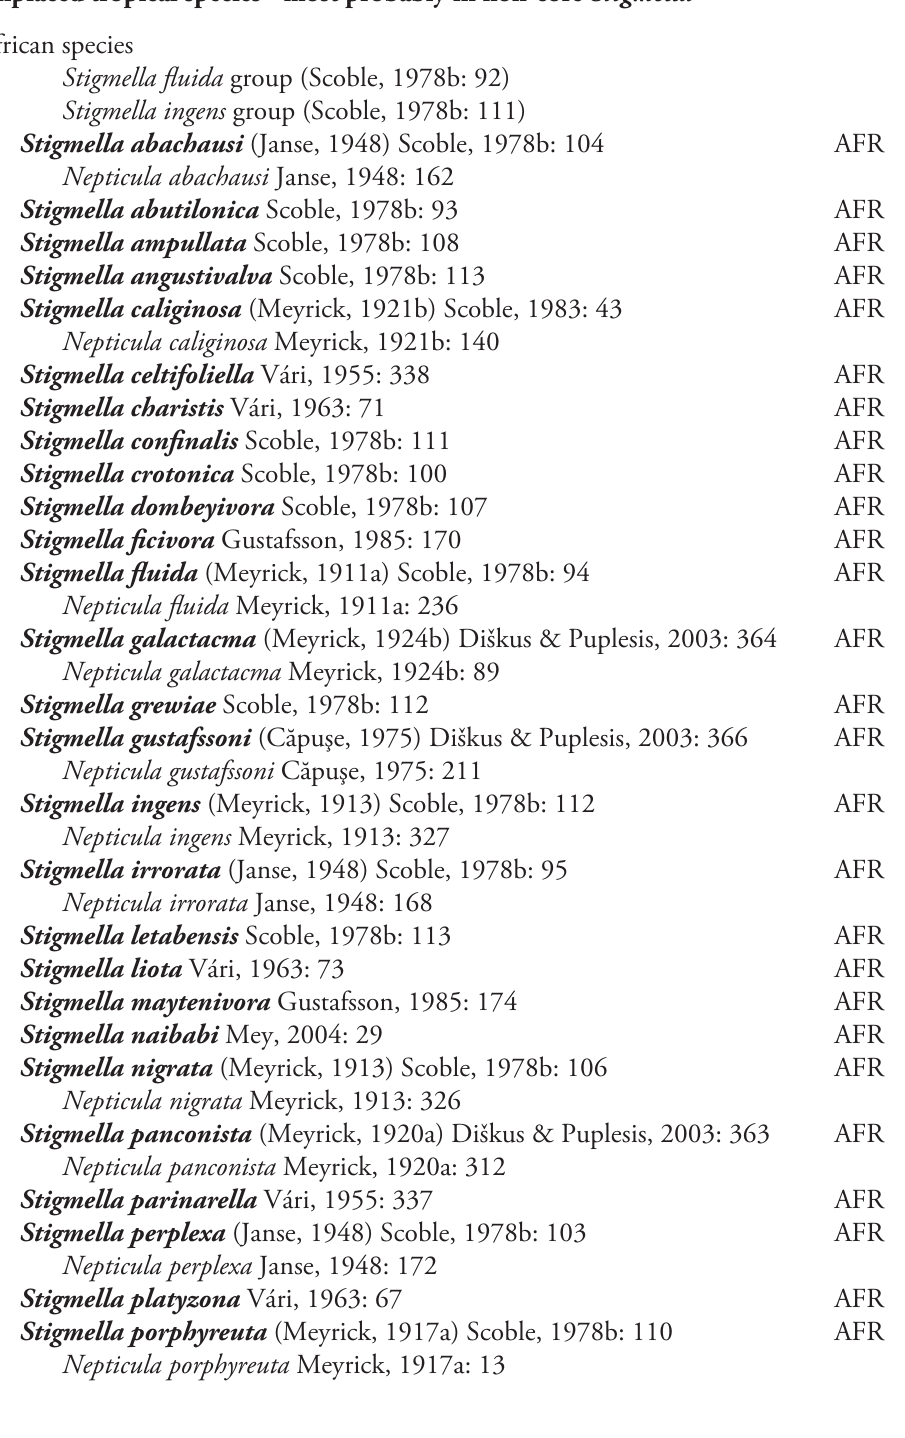
AFR AFR AFR AFR AFR AFR AFR